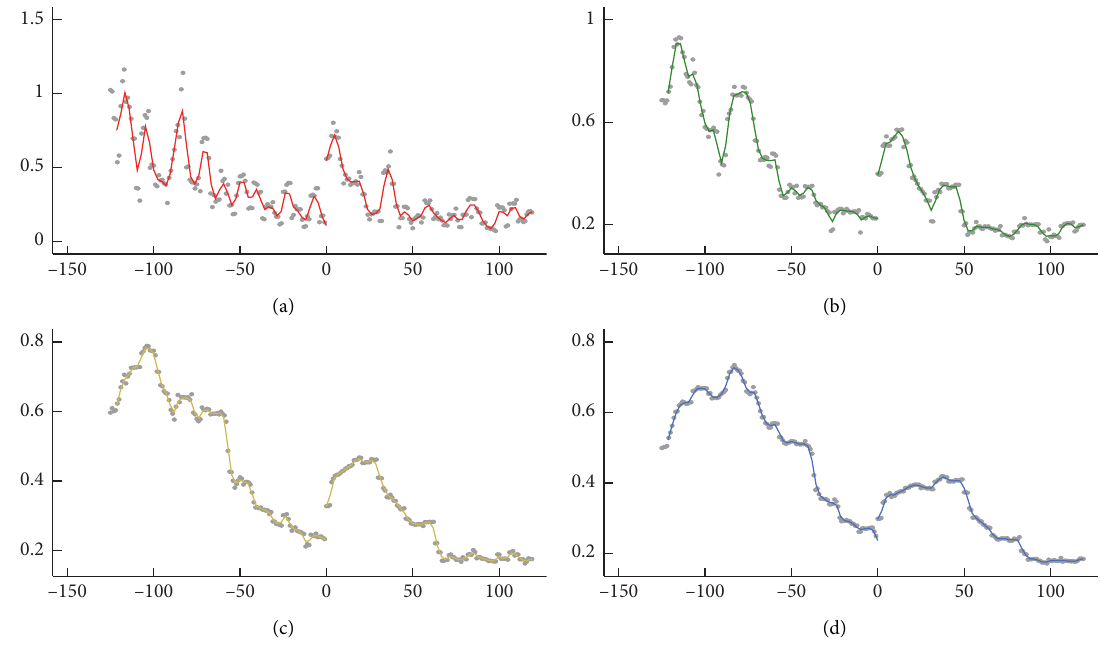
Figure 9: The RDD results of the pharmaceutical industry. (a) hv5, (b) hv15, (c) hv30, and (d) hv50.